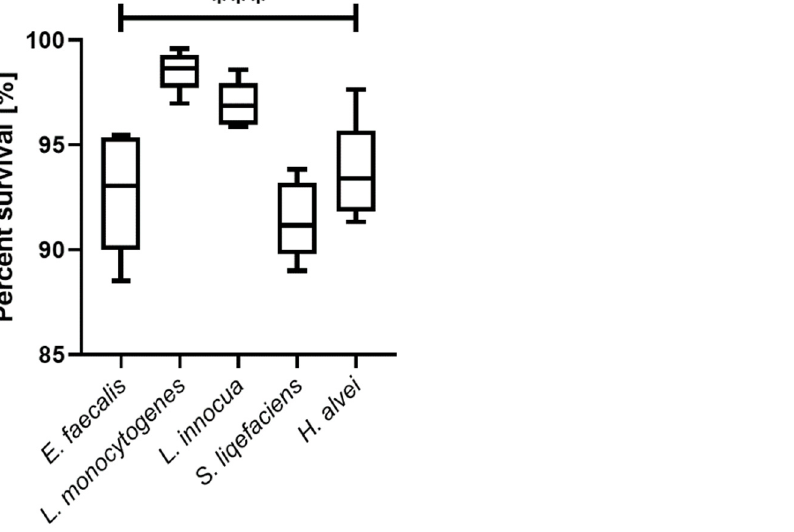
Figure 4. Survival curves of G. mollonella larvae injected with L. monocytogenes ; c—ceviche.